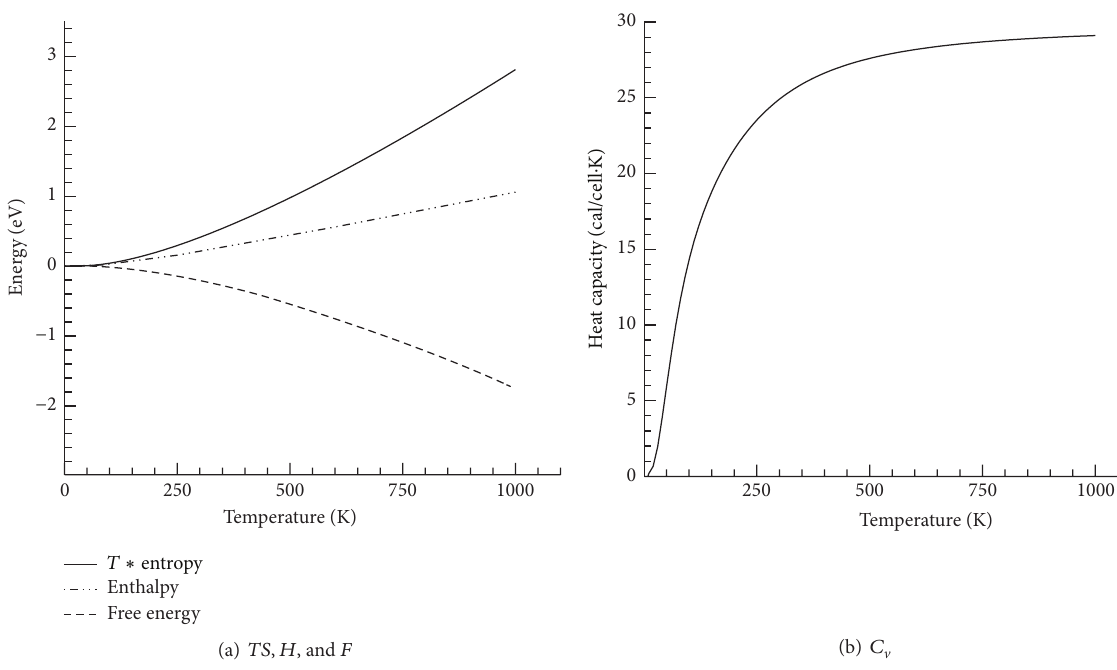
Figure 8: Temperature dependence of thermodynamic properties at 𝑎 = 3.772